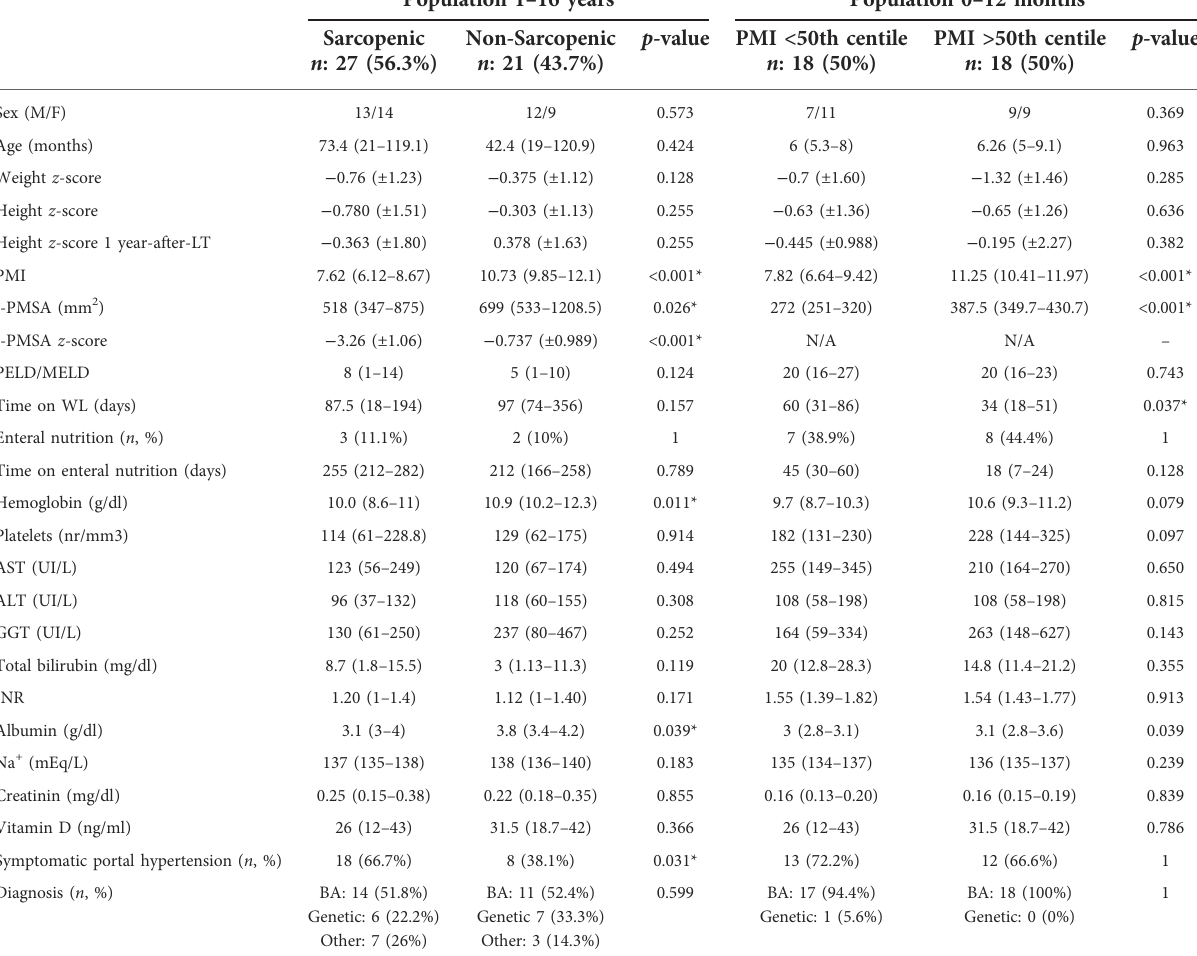
TABLE 2 Comparisons between sarcopenic and non-sarcopenic CLD